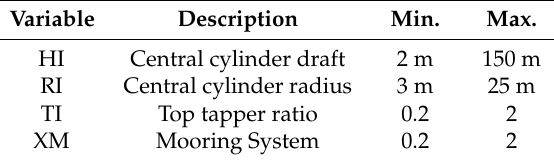
Table 6. Geometric design variables of spar buoy platform.